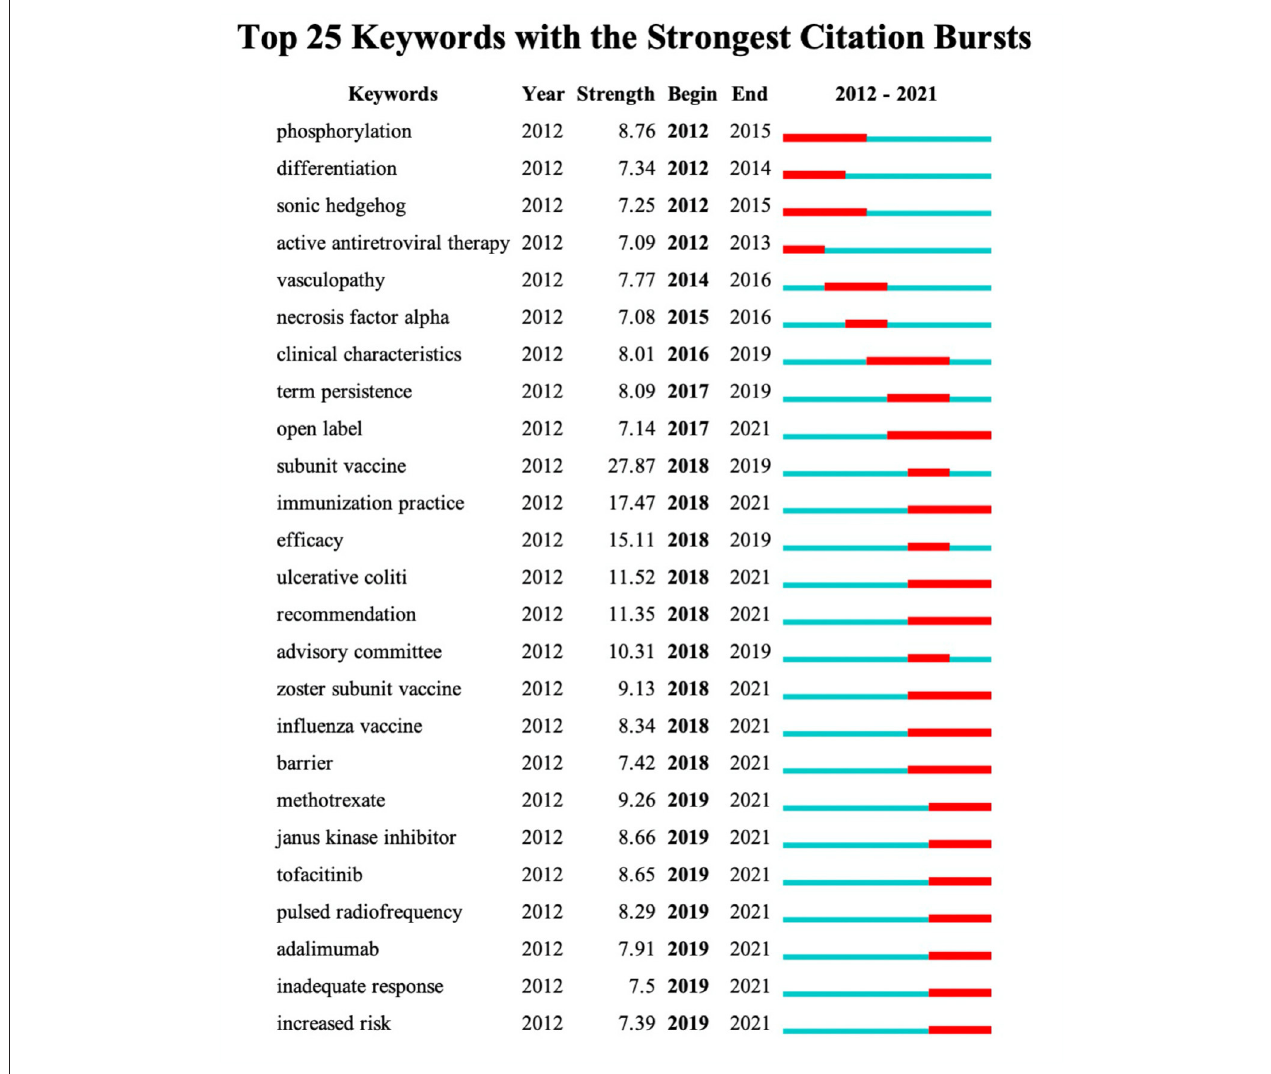
FIGURE 8 | Keywords with the strongest citation bursts in publications on herpes zoster research between 2012 and